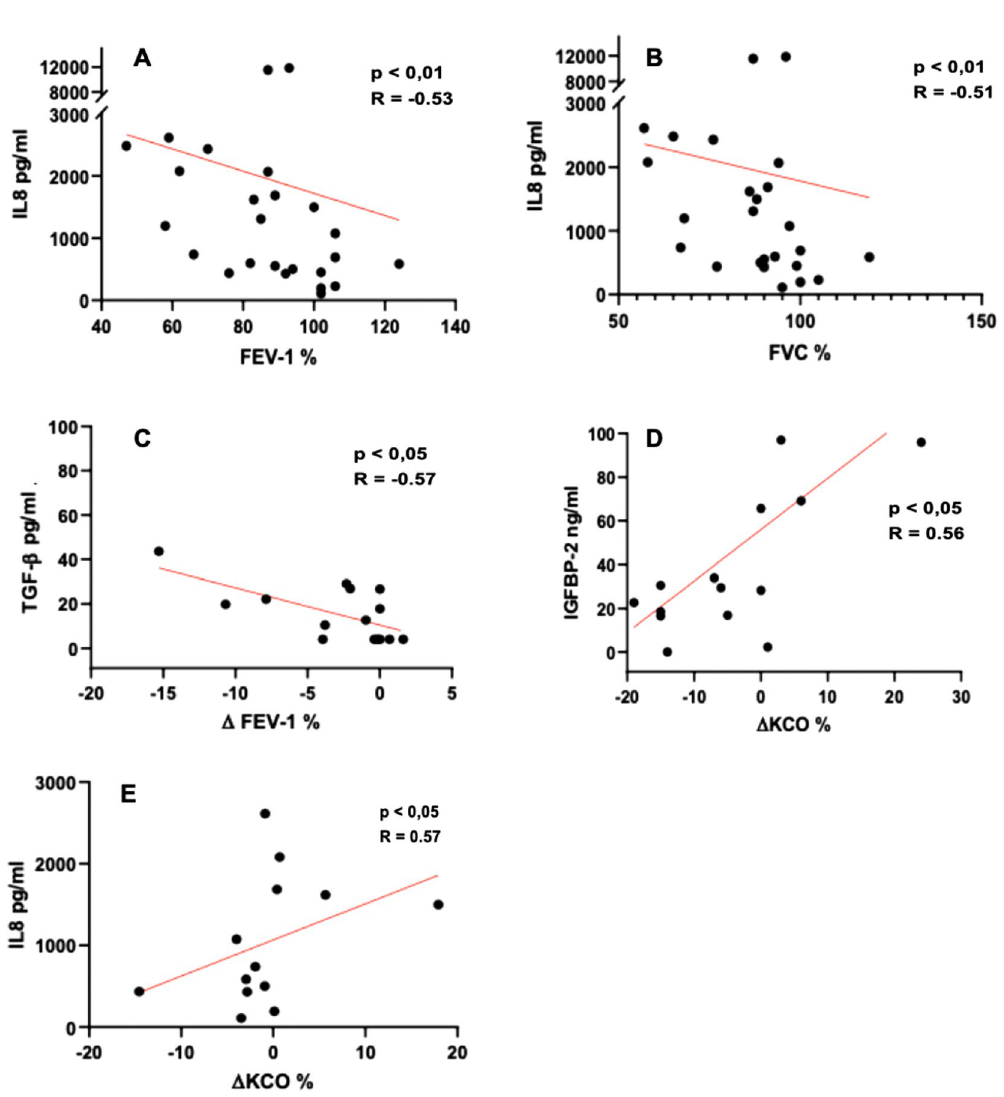
Figure 2. Correlation between sputum biomarkers and